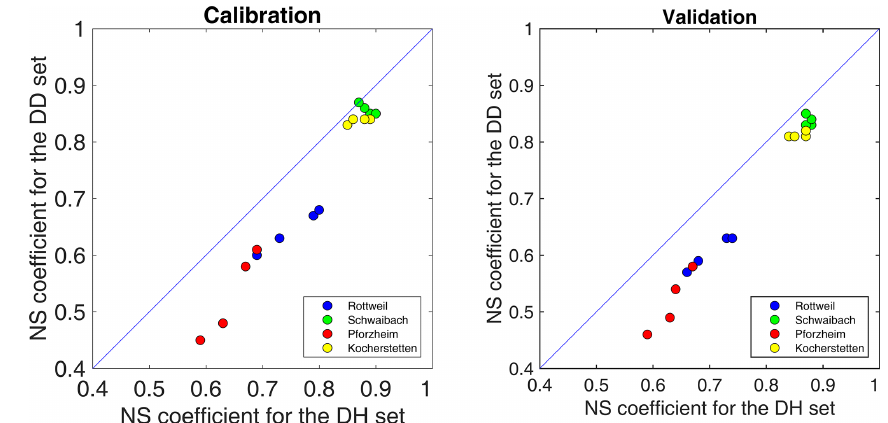
Figure 9. Comparison of the NS coefficient for using hourly and daily rainfall as model input for the DH and DD sets.